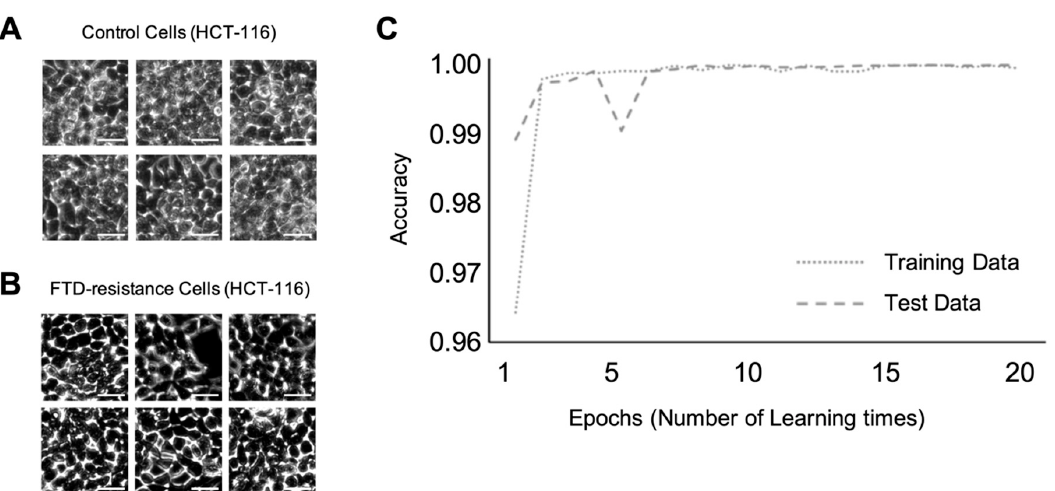
Figure 3. Machine learning at confluence level for HCT-116 cells resistant and non-resistant to anticancer drugs. Scale bar; 50µm ( A ) Representative input image of the control HCT-116 cells. Scale bar; 50µm ( B ) Representative input image of drug-resistant HCT-116 cells. ( C ) Accuracy variation per epoch.